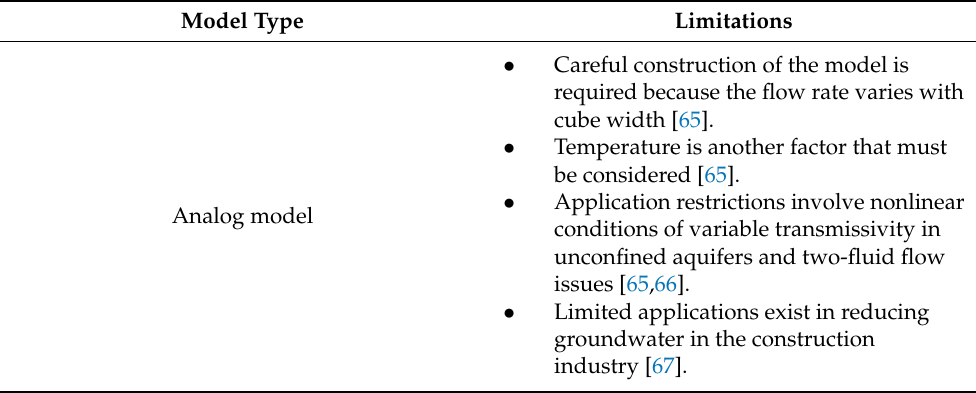
Table 1. Limitation of groundwater